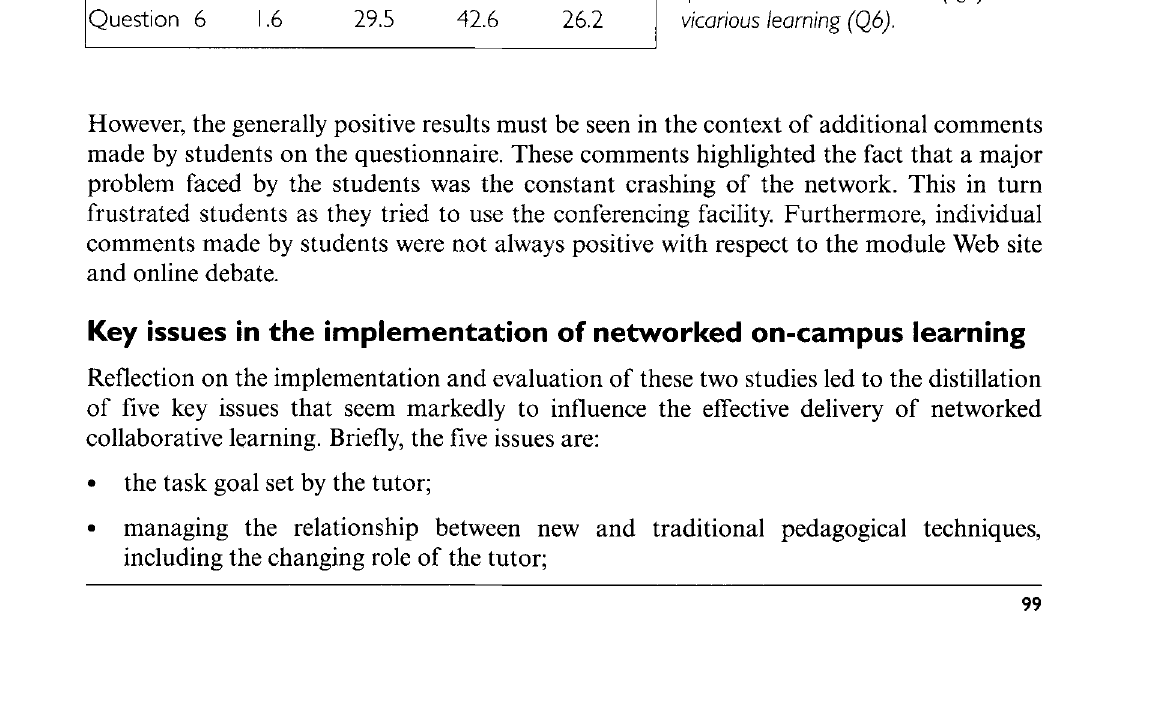
Table 2: Student scores for specific questions on critical debate (Q5) and vicarious learning